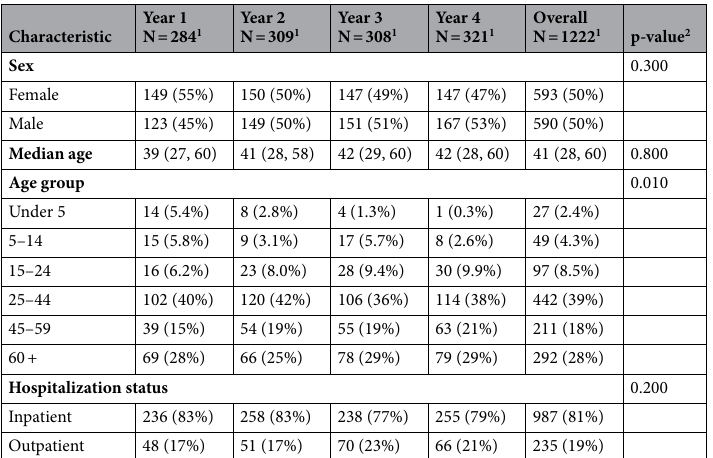
Table 1. Baseline characteristics of patients recorded during the study period. 1 n (%); Median (IQR); 2 Pearson’s Chi-squared test; Kruskal–Wallis rank sum test.